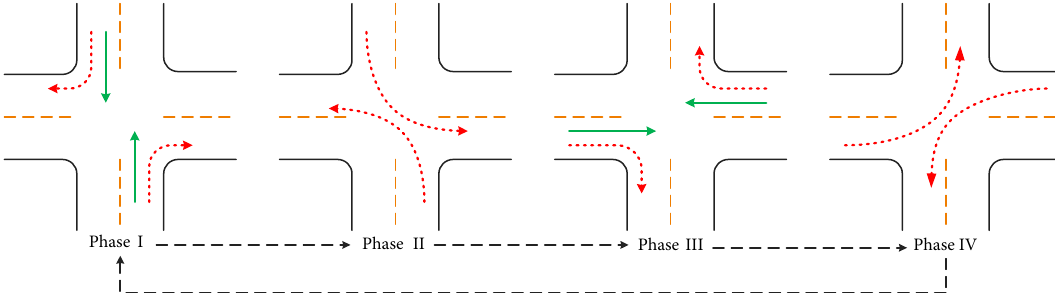
Fig. 2. Four kinds of traffic signal phase